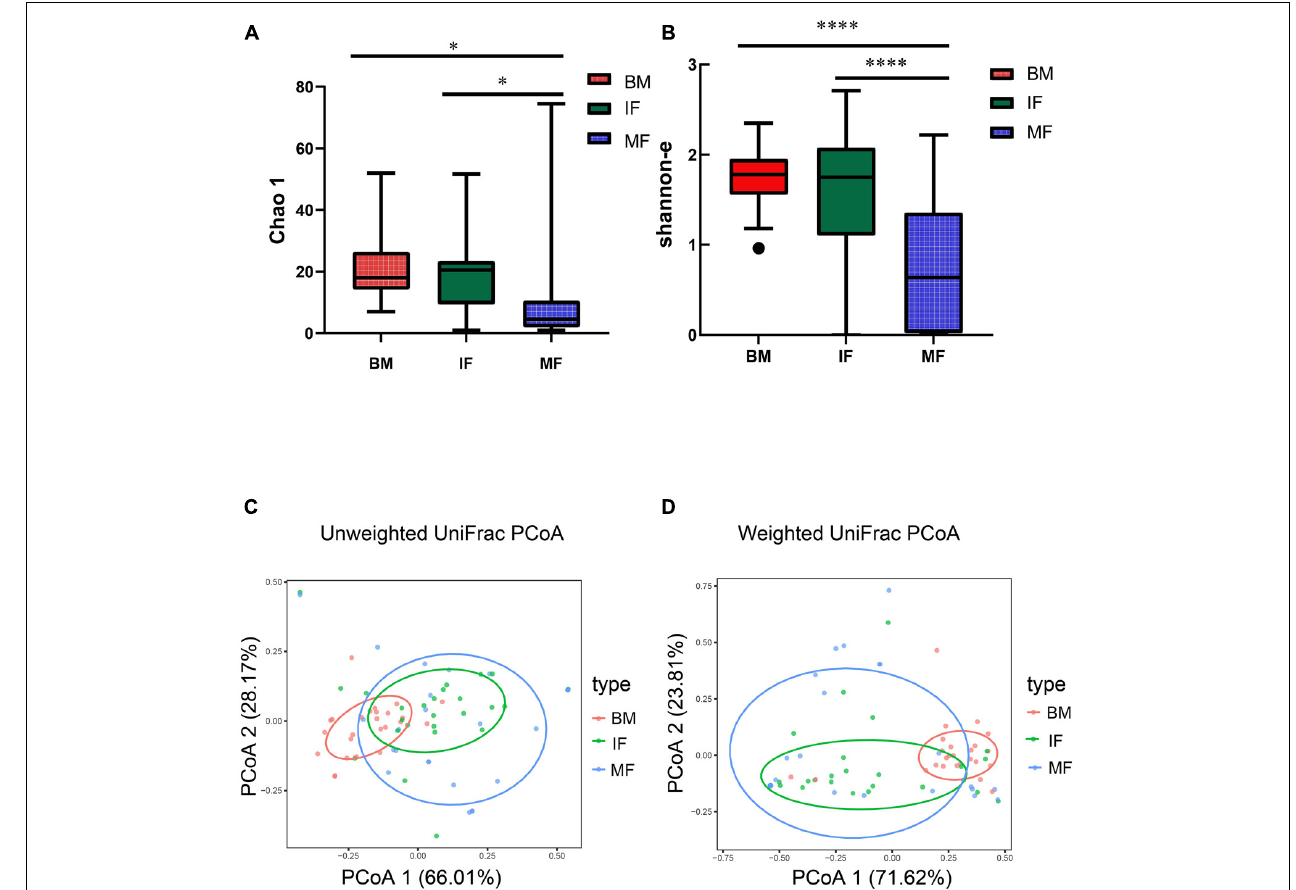
FIGURE 1 | The diversity of Lactobacillus populations in breast milk (BM), infant feces (IF), and maternal feces (MF). Box and whiskers distribution of the Chao 1 (A) and Shannon α -diversity index (B) , calculated for mother’s milk (red), infant feces (green), and maternal feces (blue). These data were analyzed by one-way ANOVA with Tukey–Kramer multiple comparisons test. Principal coordinates analysis (PCoA) of sample clustering results with an unweighted weighted UniFrac distance matrix (C) and a UniFrac distance matrix (D) . Each point represents a sample ( n = 75), colored by ecosystem: mother’s milk (red), infant feces (green), and maternal feces (blue). Ellipses represent a 95% confidence interval around the cluster centroid. In both PCoA first and second principal components (PCo1 and PCo2) are plotted. The percentage of variance in the dataset explained by each axis is reported. Statistical analysis was performed using the permutational multivariate analysis of variance (PERMANOVA). In (A,B) , *indicates p < 0.05, ****indicates p <